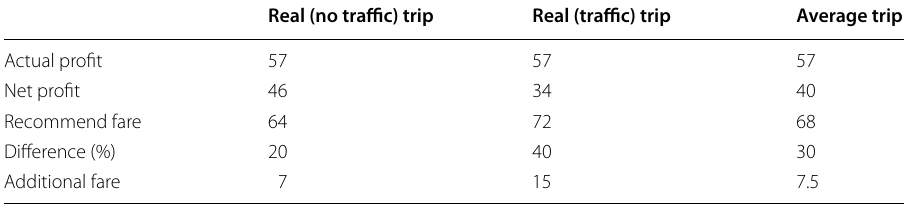
Table 3 Fare adjustment